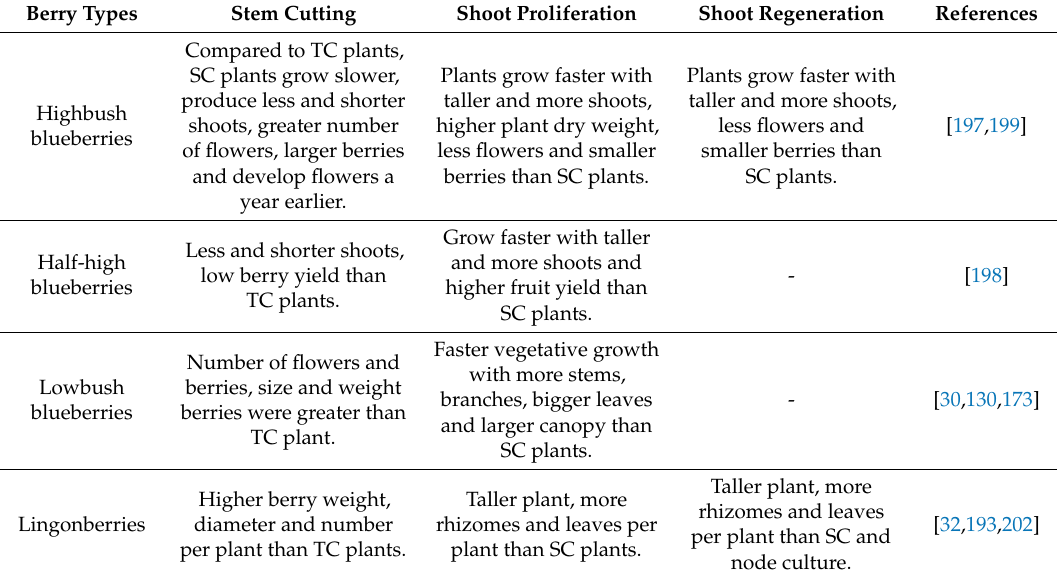
Table 4. Biochemical and morphological di ff erences among Vaccinium berry plants propagated by stem cutting (SC) and tissue culture